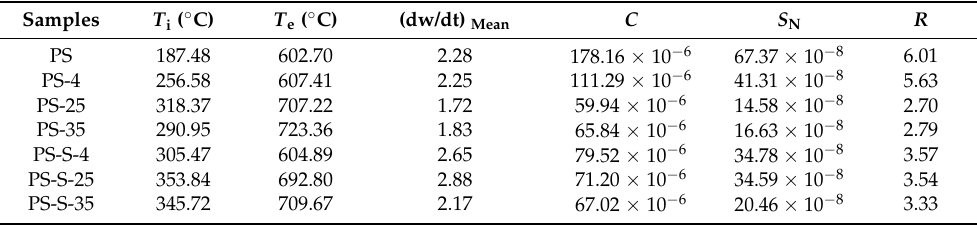
Figure 5. TG and DTG curves of ( a ) PS, ( b ) PS-4, ( c ) PS-25, and ( d ) PS-S-25 at β = 10 °C/min in air atmosphere. Table 3. The flammability index ( C ), comprehensive combustibility index ( S N ) and combustion stability ( R ) of PS